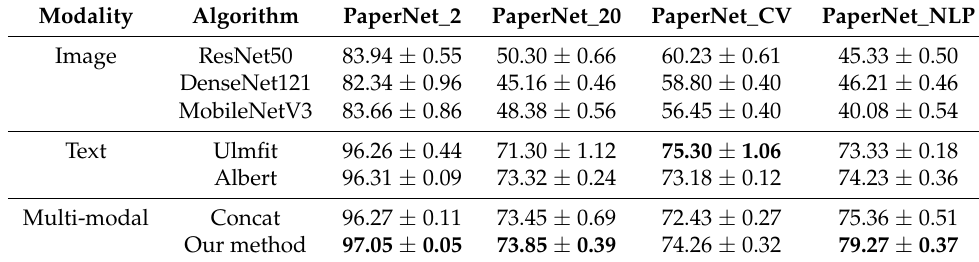
Table 3. Comparison of